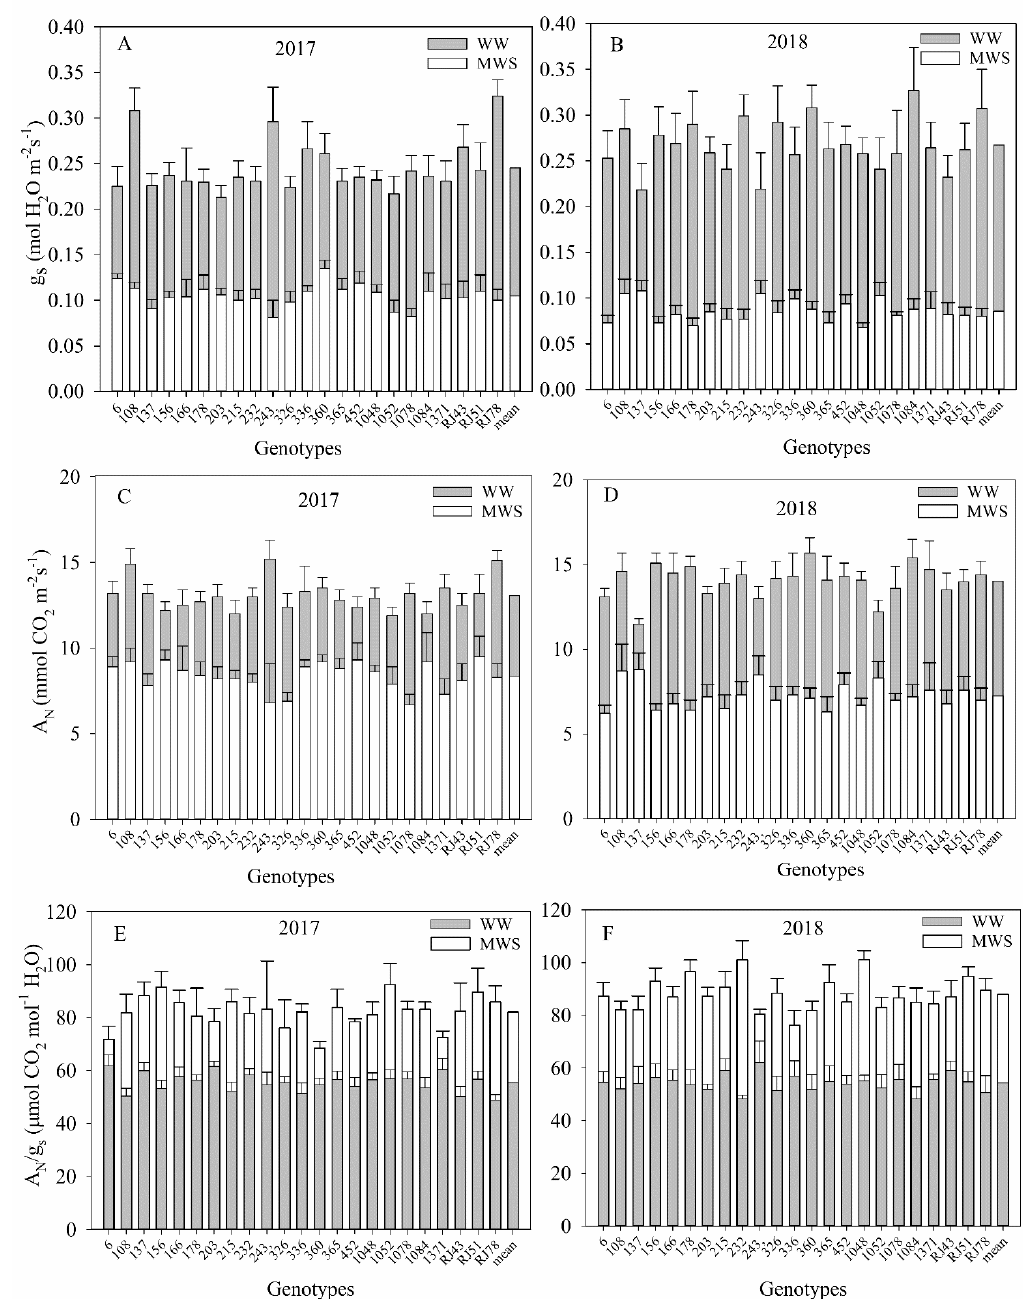
Figure 4. Leaf stomatal conductance (g s ), net photosynthesis rates (A N ) and intrinsic water use efficiency (WUE i ) for each genotype measured in 2017 ( A , C , E ) and 2018 ( B , D , F ) in well-watered (WW) (grey bars) and moderate water stress (MWS) (white bars) s. Values are the mean ± SE (n = 5). The genotype effect was significative in g s ( p value < 0.001), and in A N ( p -value < 0.05) and was not significative in WUE i ( p -value < 0.1). For both years, the maximal g s in WW was around 0.32 mol H 2 O m − 2 s − 1 and the minimal 0.21 mol H 2 O m − 2 s − 1 (Figure 4A,B). These differences were also clear in A N and WUE i (Figure 4C–F). For example, under WW condition, genotype RJ78 showed a higher g s and lower WUE i both years, with 48.8 and 50.6 μ mol CO 2 mol H 2 O − 1 , respectively. In contrast, genotype 1052 showed a low g s both years (0.21 and 0.24 mol H 2 O m − 2 s − 1 ) and not a high WUE i (57 and 52 μ mol CO 2 mol H 2 O − 1 , respectively). Under MWS treatment, the variation of WUE i was around 20 μ mol CO 2 mol H 2 O − 1 , reaching first year study genotypes 1052 and 156 around 90 μ mol CO 2 mol H 2 O − 1 , and genotypes 1371 and 6 to 70 μ mol CO 2 mol − 1 H 2 O. The second year of study, genotypes